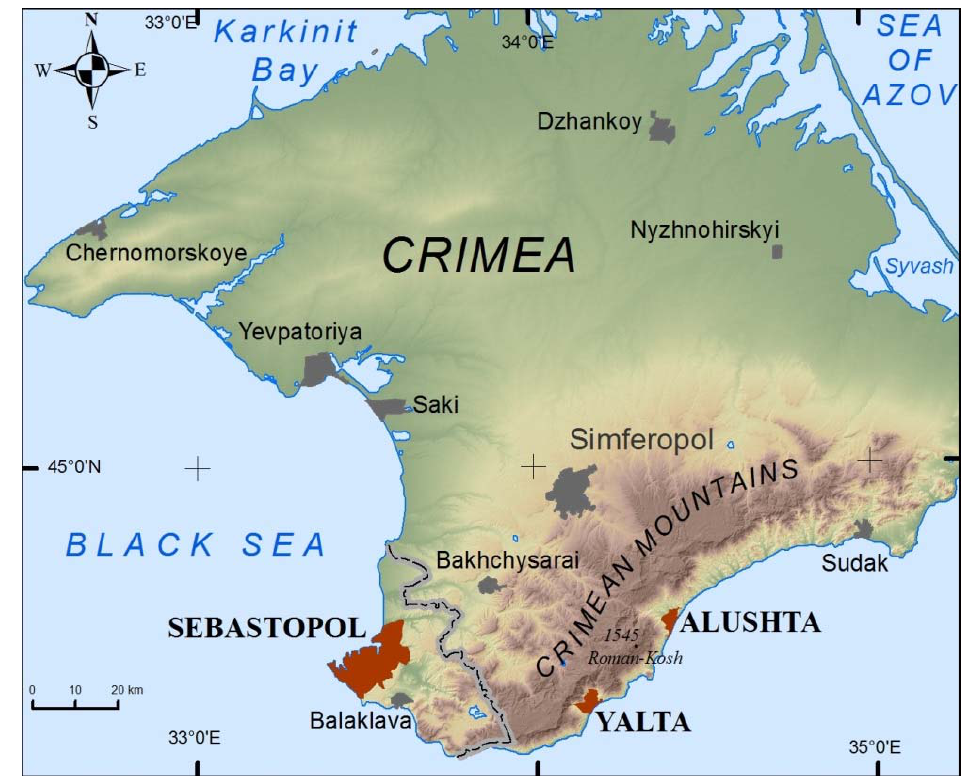
Figure 1. Study objects